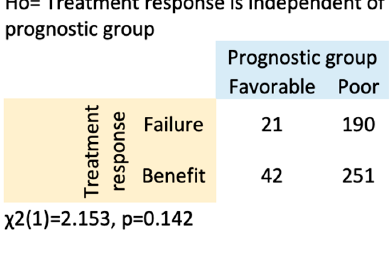
Figure 2 . The clinical benefit in any given line was independent of the IMDC prognostic risk group. A chi-square analysis comparing treatment response in favorable- and intermediate- or poor-risk prognosis groups. In this analysis, intermediate and poor risk patients were combined; the combined group is labeled as, “Poor”.